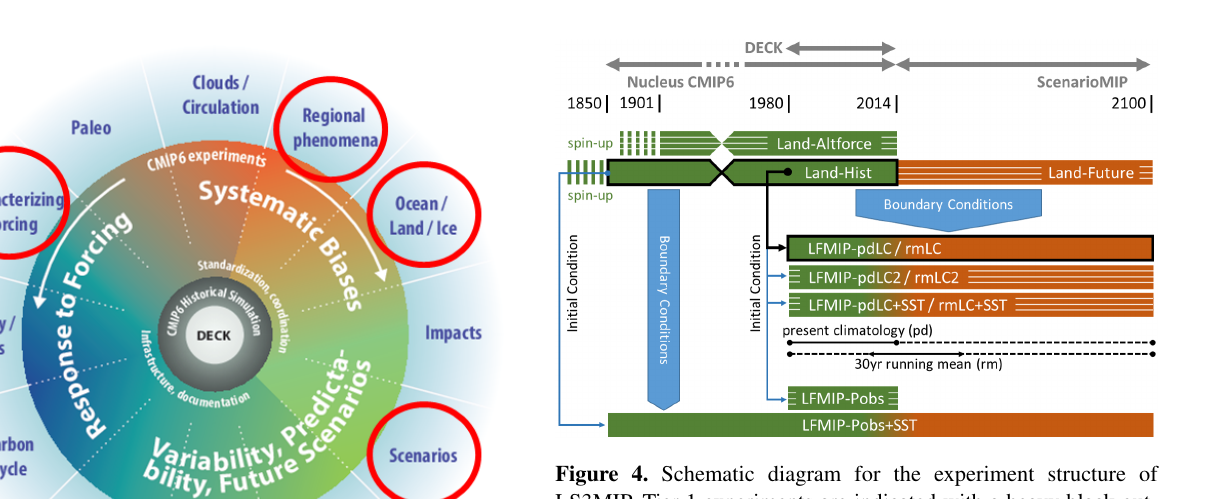
Figure 2. Relevance of LS3MIP for WCRP Core Projects and Grand Challenges 2 .